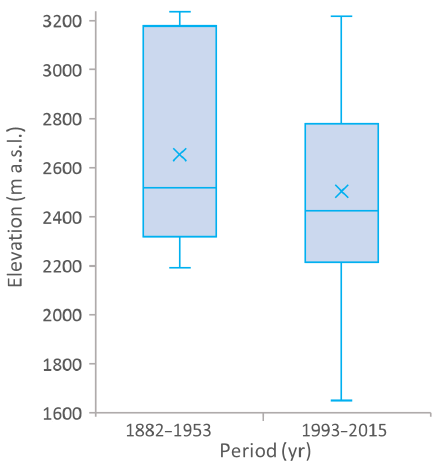
Figure 9. Boxplots for the elevations of the main deposits of snowfall-driven G-CHs during the periods 1882–1953 and 1993–